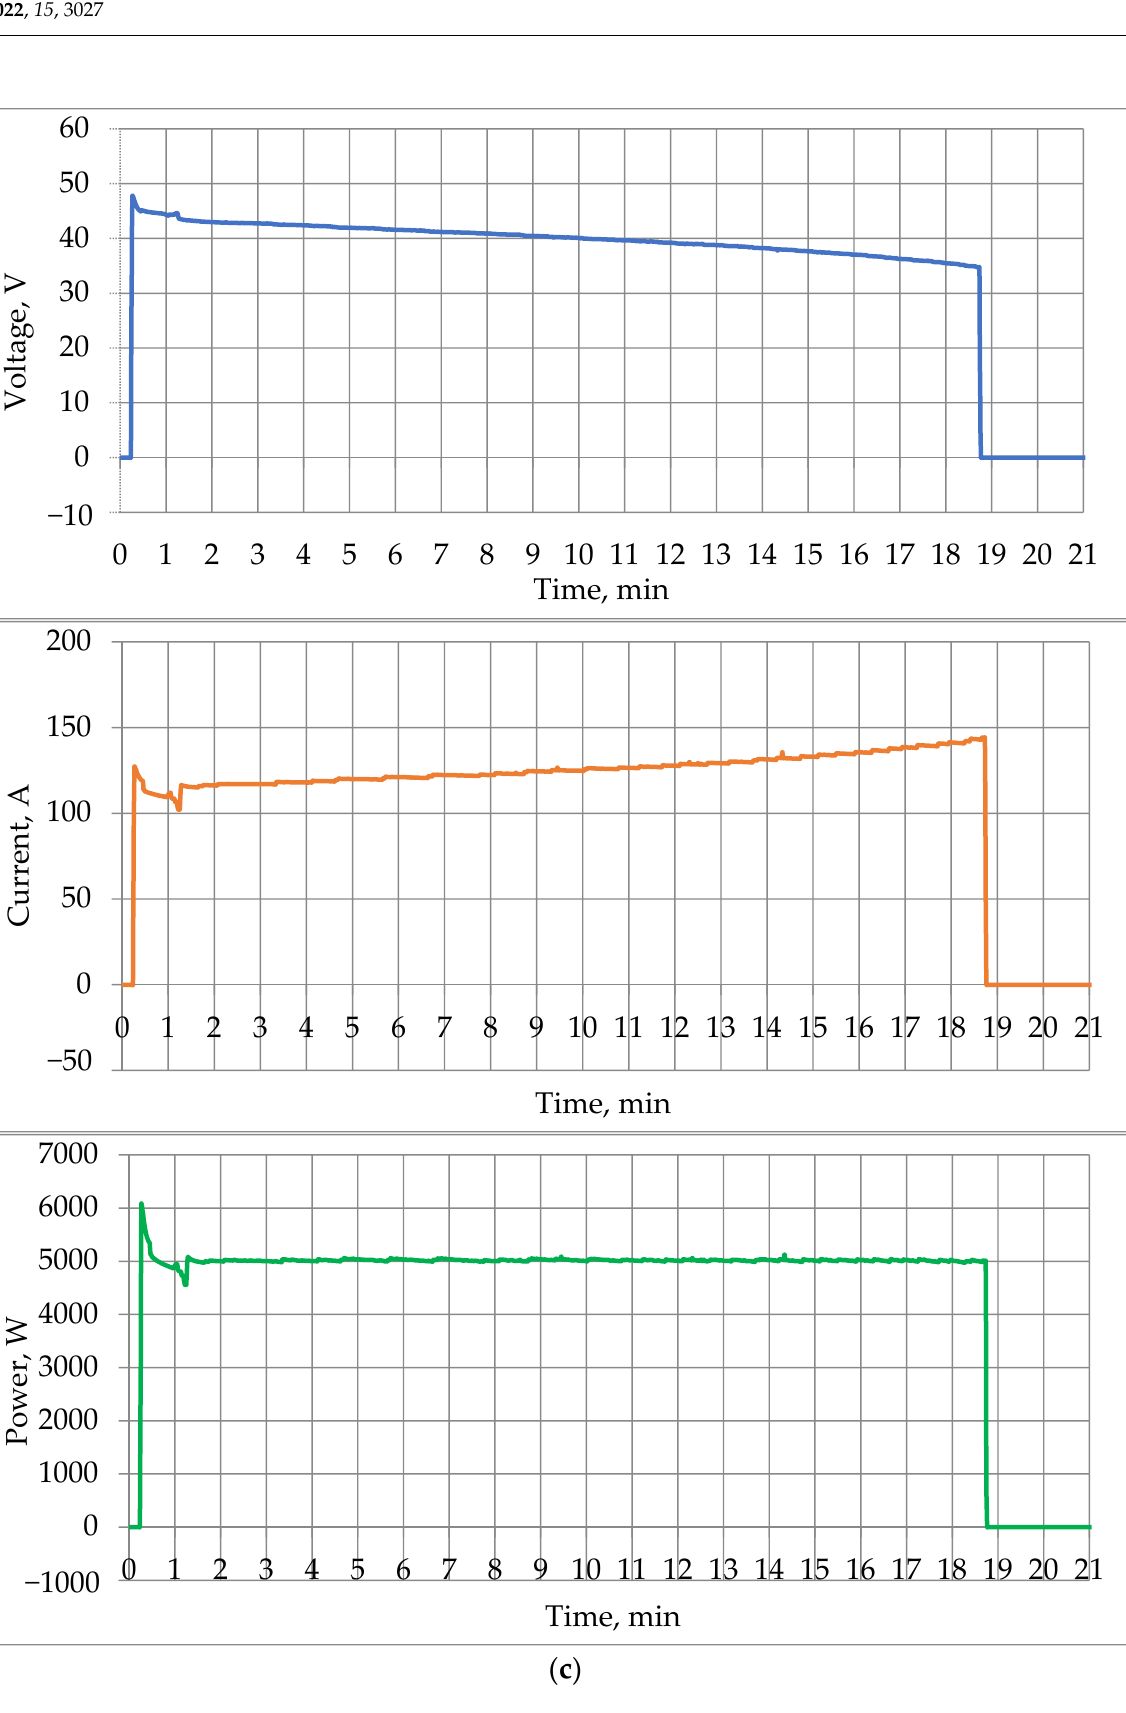
Figure 10. VRFB test results (voltage, current and power) in the following modes: charge/discharge ( a ); when connecting the load ( b ); when connecting a constant power load ( c ).